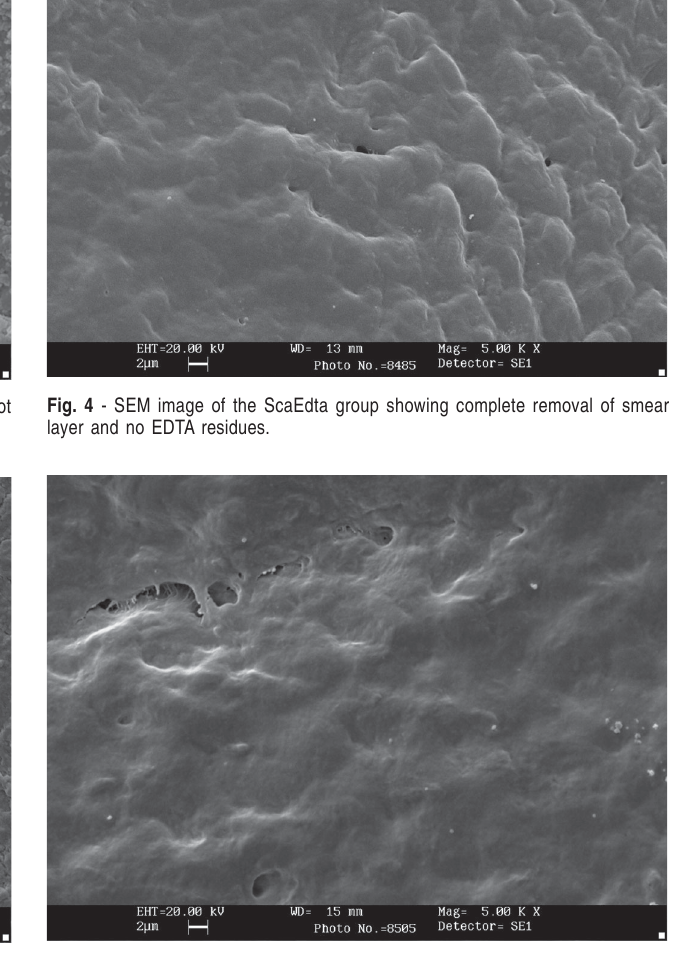
Fig. 5 - SEM image of the ScaCi group showing complete removal of smear layer and no citric acid